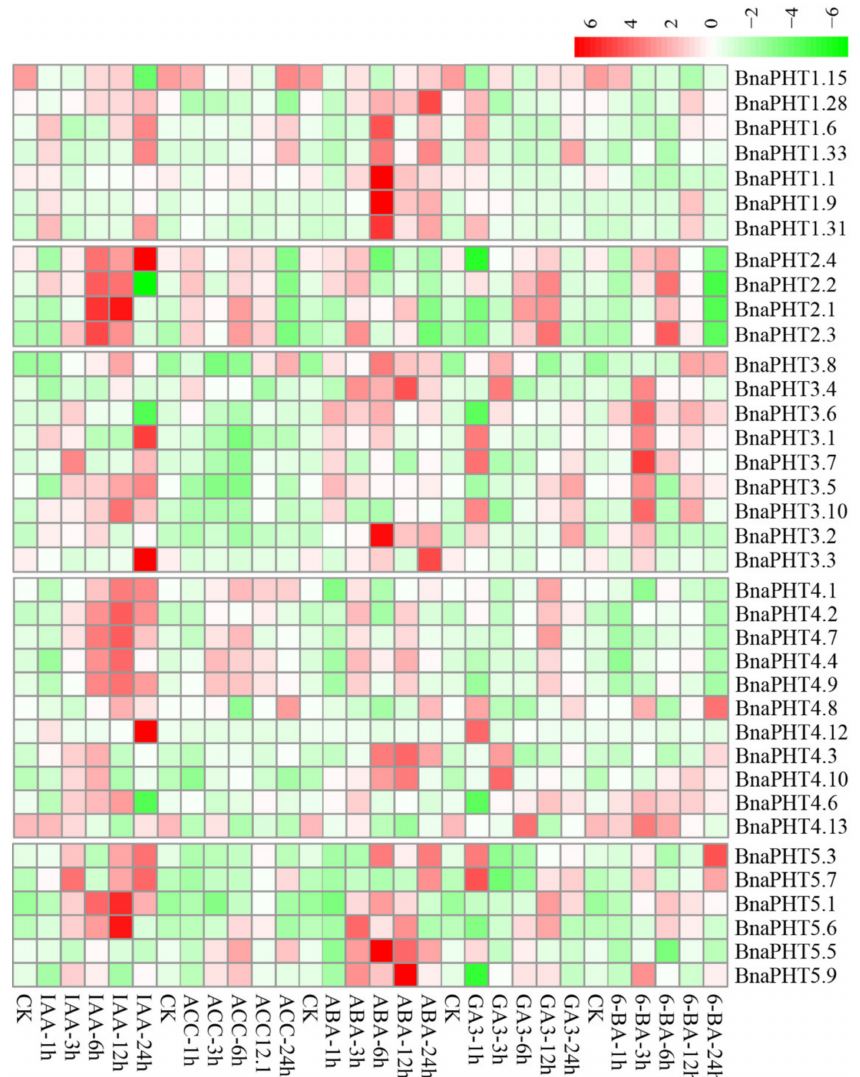
Figure 7. Expression profiles of BnaPHTs under five hormone inductions in B. napus seedling roots by RNA-seq. CK: no extra hormone inductions (0 h), IAA: indoleacetic acid, ACC: 1-amino cyclopropanecarboxylic acid, ABA: abscisic acid, GA 3 : gibberellin acid 3, 6-BA: cytokinin. The “1 h”, “3 h”, “6 h”, “12 h”, and “24 h” represent hours after treatment. The color bar in the upper right represents log2 expression values (FPKM ≥ 1): green represents low expression and red represents high